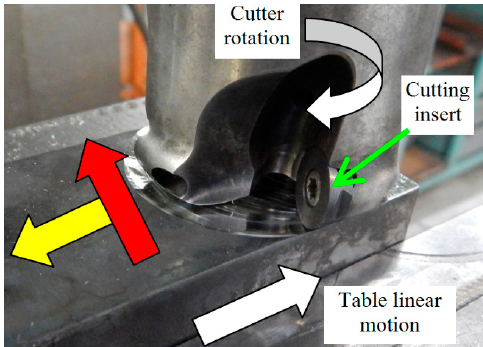
Figure 2. Illustration of hard milling process kinematics, (red arrow—direction of v c , tangential; yellow arrow—direction of v f , axial).